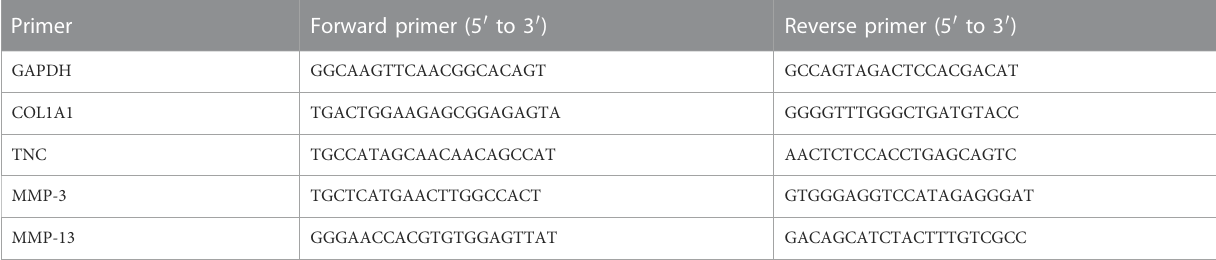
TABLE 1 Sequences of primers for